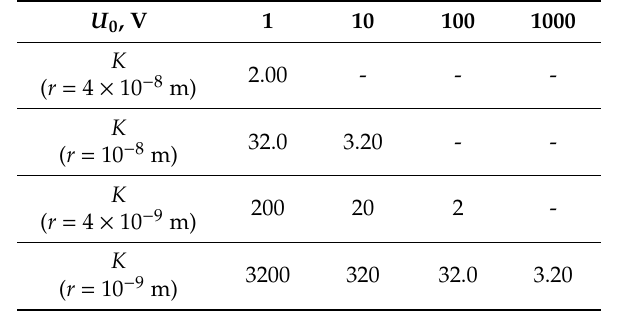
Table 4. Values of the coe ffi cient K = p d at di ff erent values of the distances r between the interacting p c charges, corresponding to the roughness of the surfaces to be joined, at di ff erent applied electric voltages.